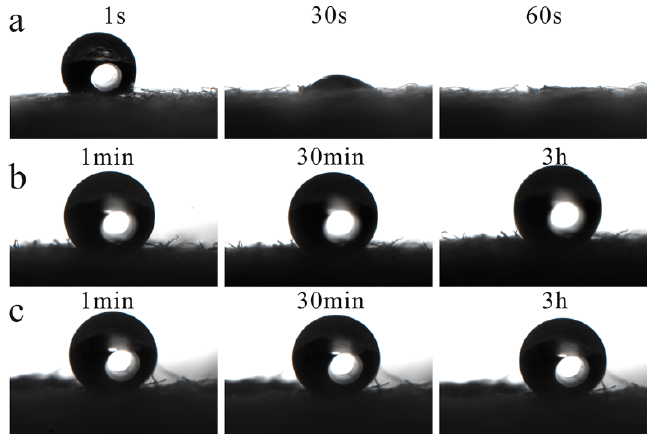
Figure 15. The contact angles of paper at different pH conditions: ( a ) pH = 1; ( b ) pH = 7; ( c ) pH = 14.